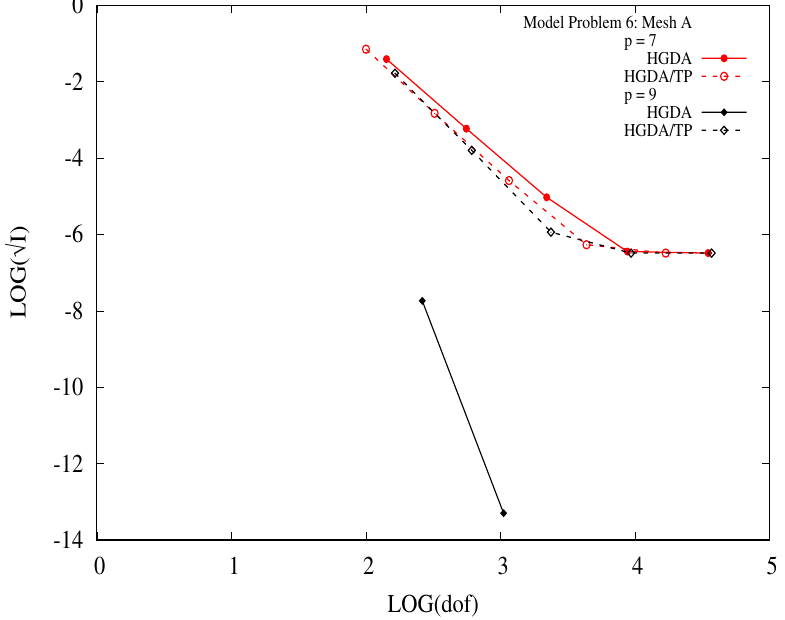
Figure 30. Residual function I versus dof, C 33 solutions: Model Problem 6 (Burgers Equation; Mesh A; HGDA/DG and